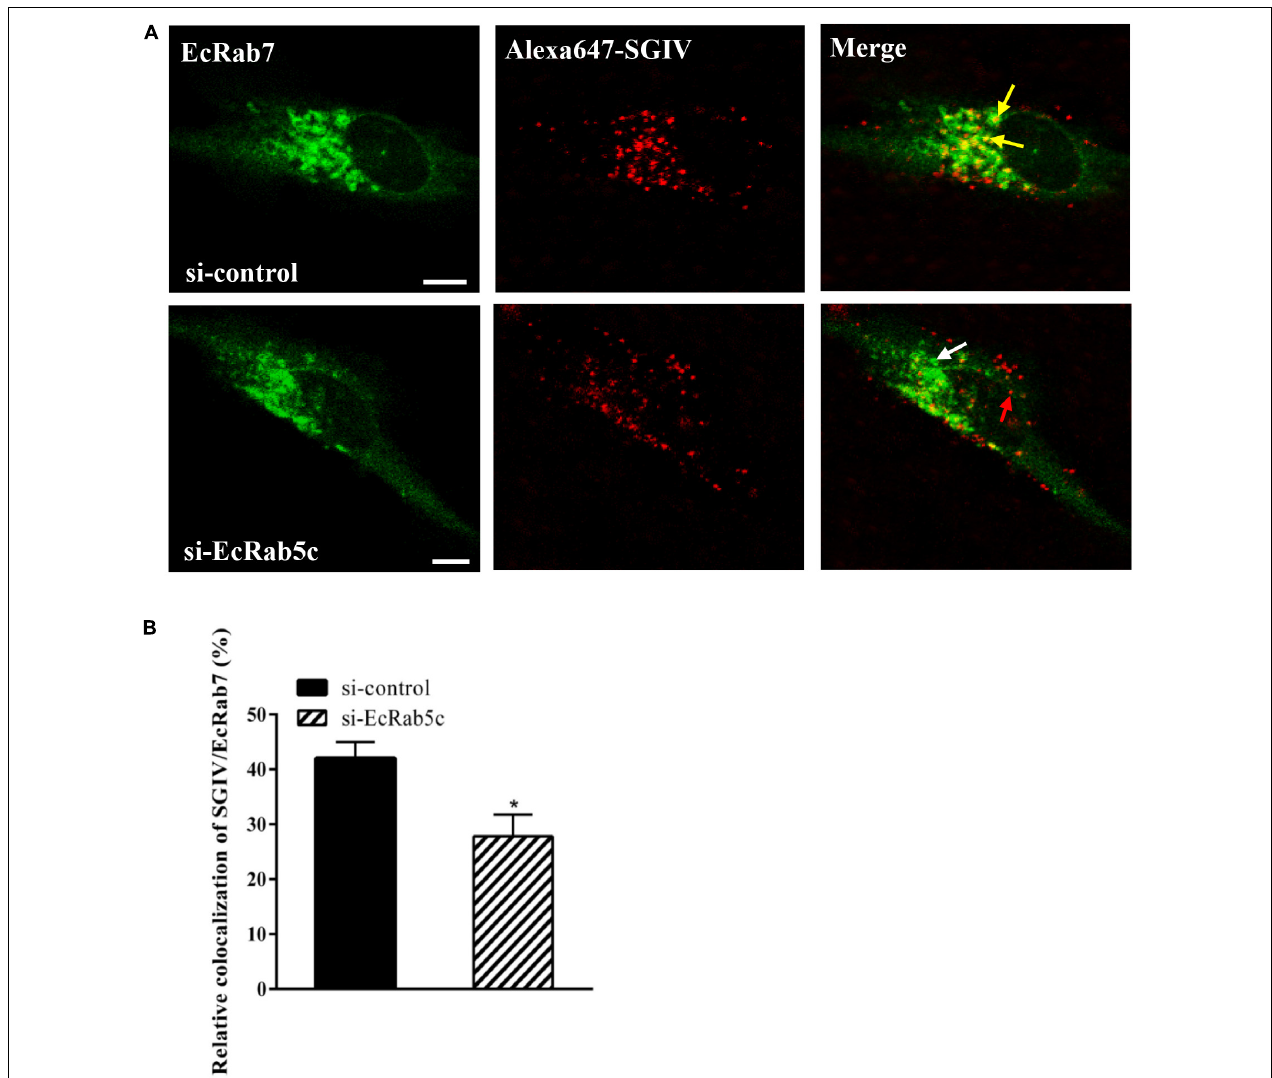
FIGURE 5 | Knockdown of EcRab5c affect the colocalization of SGIV and EcRab7. (A) The confocal images of the colocalization between SGIV and EcRab7 in si-control or si-EcRab5c transfected cells. GS cells co-transfected with si-control/pEGFP-EcRab7 or si-EcRab5c/pEGFP-EcRab7 were incubated with Alex-Fluor 647 labeled SGIV at 4 ◦ C for 20 min, transferred to 28 ◦ C, and then were fixed at 1 hpi. Yellow arrows indicated the SGIV colocalized with EcRab7. White arrow indicated single EcRab7 signal. Red arrow indicated single SGIV signal. Scale bars represent 5 µ m. (B) Quantification of SGIV particles colocalized with EcRab7 in (A) . Over 90 cells were randomly chose and analyzed by MATLAB program. The colocalization of SGIV/EcRab7 was quantified as the percentage of SGIV particles colocalized with EcRab7 to the total internalized virus particles. The colocalization of SGIV and EcRab7 in control cells was arbitrarily set as 100%. The data are indicated as the mean ± SEM. * p <